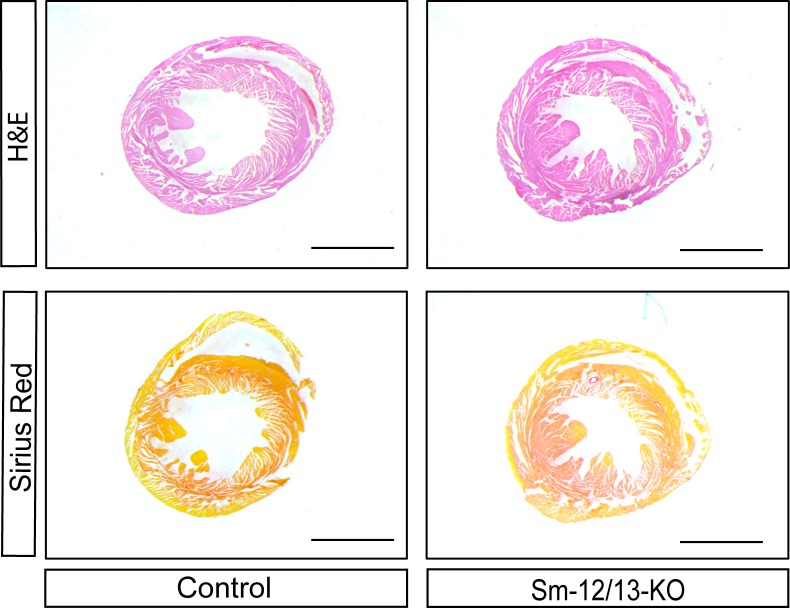
Hearts of wild-type (control) and Sm-12/13-KO mice were stained 34 weeks after tamoxifen induction with hematoxylin and eosin (H and E), as well as picrosirius red.Scale bar: 5 mm.